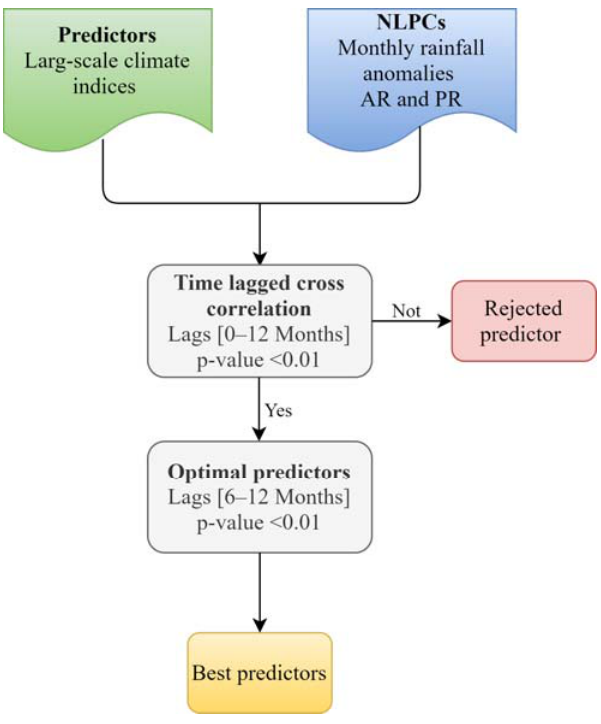
Figure 4. Predictor selection